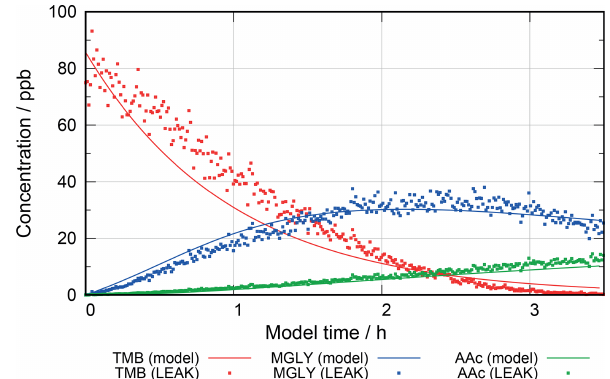
Figure 18. Comparison of measured (squares) and modelled (lines) gas-phase volume mixing ratios for 1,3,5-trimethyl benzene (TMB, red), methylglyoxal (MGLY, blue), and acetic acid (AAc, green) in the model scenario RXN 0 . 4